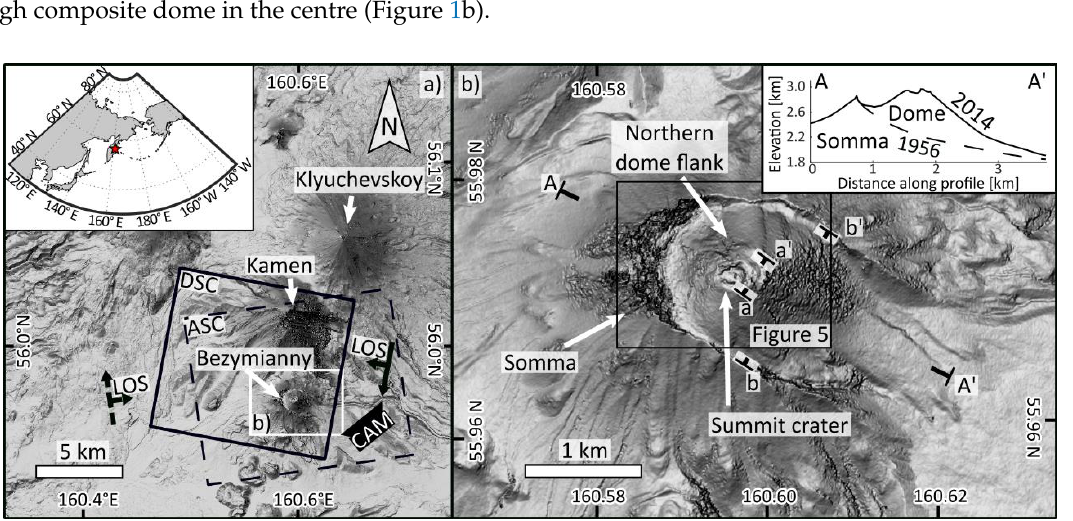
Figure 1. ( a ) Shaded relief map (TanDEM digital elevation model from 2014) of Bezymianny and its closest neighbouring volcanoes in Kamchatka, Far East Russia (star in inset map). Location of the time-lapse camera and footprint of the TerraSAR-X (TSX) satellite are indicated by CAM and black box, respectively. Orthogonal arrows show flight and line-of-sight (LOS) directions of the descending (DSC) and ascending (ASC) TSX satellites, respectively. ASC is shown in dashed lines, as this paper focuses on the more regular DSC data. White box denotes area shown in ( b ). ( b ) Close-up shaded relief map of Bezymianny showing the 1956 collapse scar (somma), the subsequently evolved central composite dome, and its recent summit crater. Profile A-A’ indicates approximate 1956 collapse plane (dashed line). Small letter profiles a–a’ and b–b’ show landmarks that are used for scale approximation of camera images.